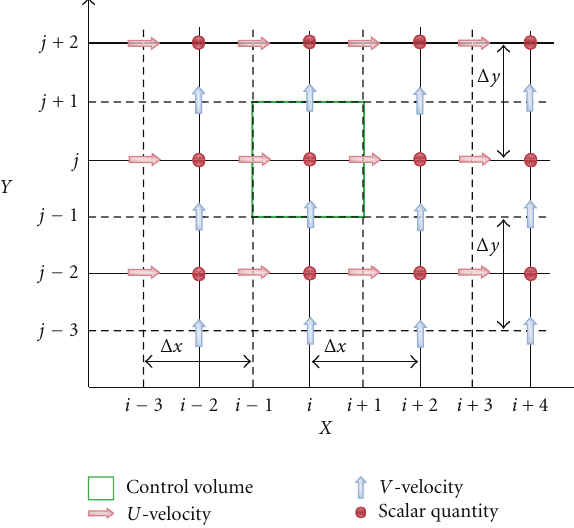
Figure 2: 2D computational staggered